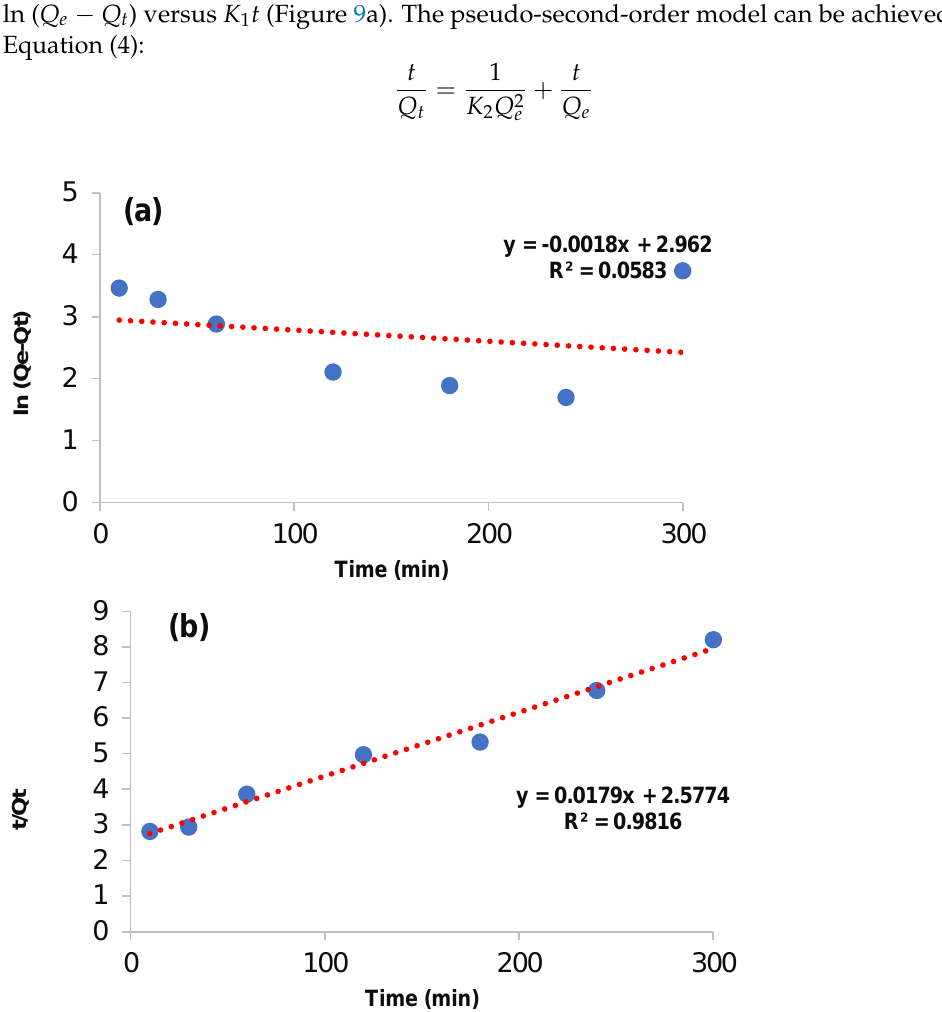
Figure 9. Linear form of ( a ) pseudo-first-order and ( b ) pseudo-second-order. Q e (mg · g − 1 ) and Q t (mg · g − 1 ) are the same parameters described in Equation (4). K 2 (L · min − 1 ), the constant rate of pseudo-second-order model, and Q e are gained through the gradient and intercept of the line from drawing t / Q t vs. t (Figure 9b). The parameters data are listed in Table 2, which indicating that the adsorption kinetic followed the pseudo- second-order model. Table 2. Kinetic parameters and values for arsenic ion uptake onto adsorbent.